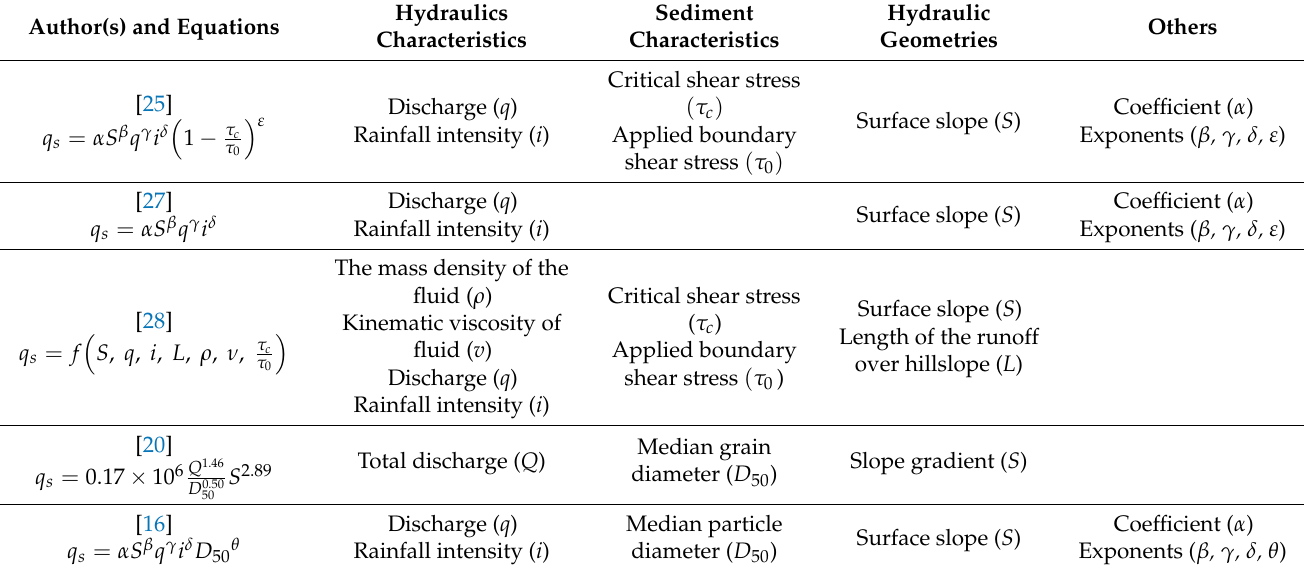
Table 3. The factors that govern or promote water erosion in terms of sediment